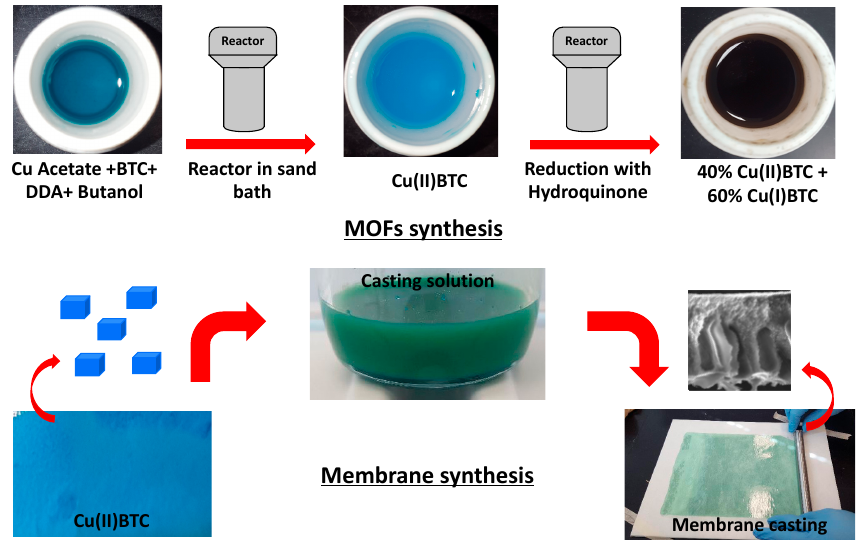
Figure 1. Schematic representation of fabrication of metal-organic frameworks (MOFs) and mixed-matrix membranes (MMMs).